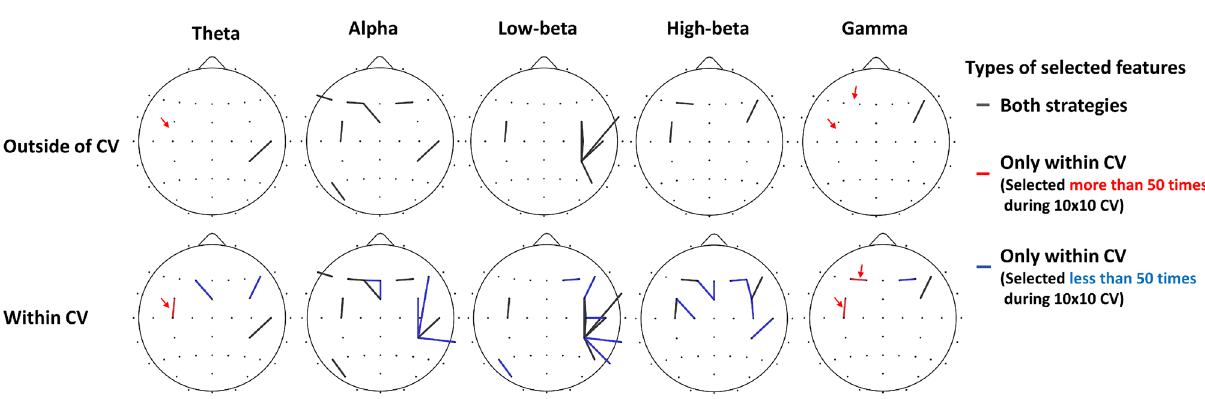
Figure 4. Spatial distribution of selected EEG features extracted from clinical EEG data when a vote threshold was 90 for the two feature selection approaches (outside of CV vs. within CV). Upper row and bottom row represent the spatial distributions of features selected by the outside of CV method and within CV method, respectively. Black lines represent the same features selected by the both feature selection approaches. Red and blue lines indicate the features selected by the within CV method more than and less than 50 times during 10 × 10 CV, respectively, but not selected by the outside of CV method at Spatial distribution and overlap ratio of EEG features. Figure 4 shows the representative spatial distributions of selected EEG features extracted from the clinical EEG data for each feature selection strategy (outside of CV vs. within CV) when a vote threshold was 90. In the case of feature selection performed outside of CV, 19 features fixed before CV were used for classifying two groups (upper row). In contrast, in the case of fea- ture selection performed within CV, more features were selected because different features were selected in each CV step. All features selected by the outside of CV method were overlapped with those selected by the within CV method (black lines), but some important features were not captured by the outside of CV method (red and blue lines in bottom row). Particularly, the three features selected by the within CV (one theta connection and two gamma connections, denoted by a red arrow) were not selected by the outside of CV method even though they were selected by the within CV method more than 50 times during 10 × 10 CV. Note that the three features were closely associated with the patients’ neurophysiological traits from the clinical point of view; PTSD patients generally showed the abnormal functional connectivity in frontal areas for theta and gamma frequency bands, and they were closely related to patients’ clinical symptoms, such as rumination and re-experiences 17–20 . Based on the result, it can be reasonably thought that some crucial features, which should be used to train a precise classification model, were discarded by the feature selection performed outside of CV. Figure 5 represents the average overlap ratios with respect to the number of selected features. The overlap ratio was kept under the 30% and it was saturated after about 10 features were selected, meaning that features selected by the two feature selection approaches were significantly different.